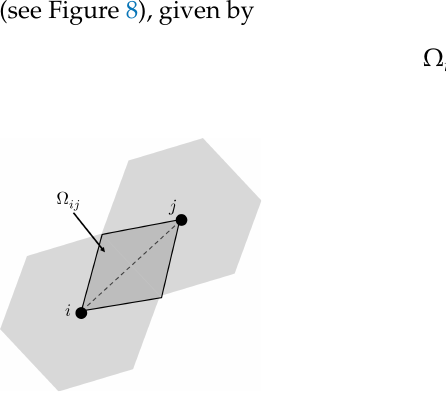
Figure 8. Influence area of each interaction.